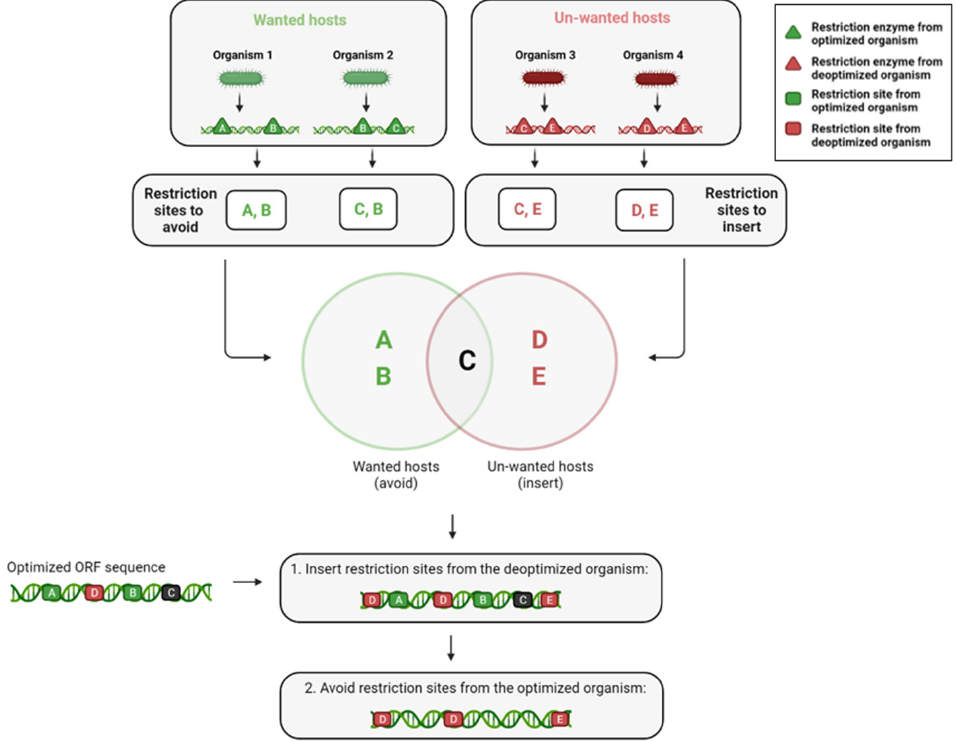
Figure 8. Classification of restriction sites and insertion of relevant discovered sites. The restriction enzymes (triangles) are extracted from the optimized and deoptimized organisms respectively. The selected restriction sites (squares) are the sites that contain the restriction enzymes exclusive to the deoptimized organisms. Then, the restriction sites from the deoptimized organisms are added to the sequence and the restriction sites from the optimized organisms are removed to yield the final product.